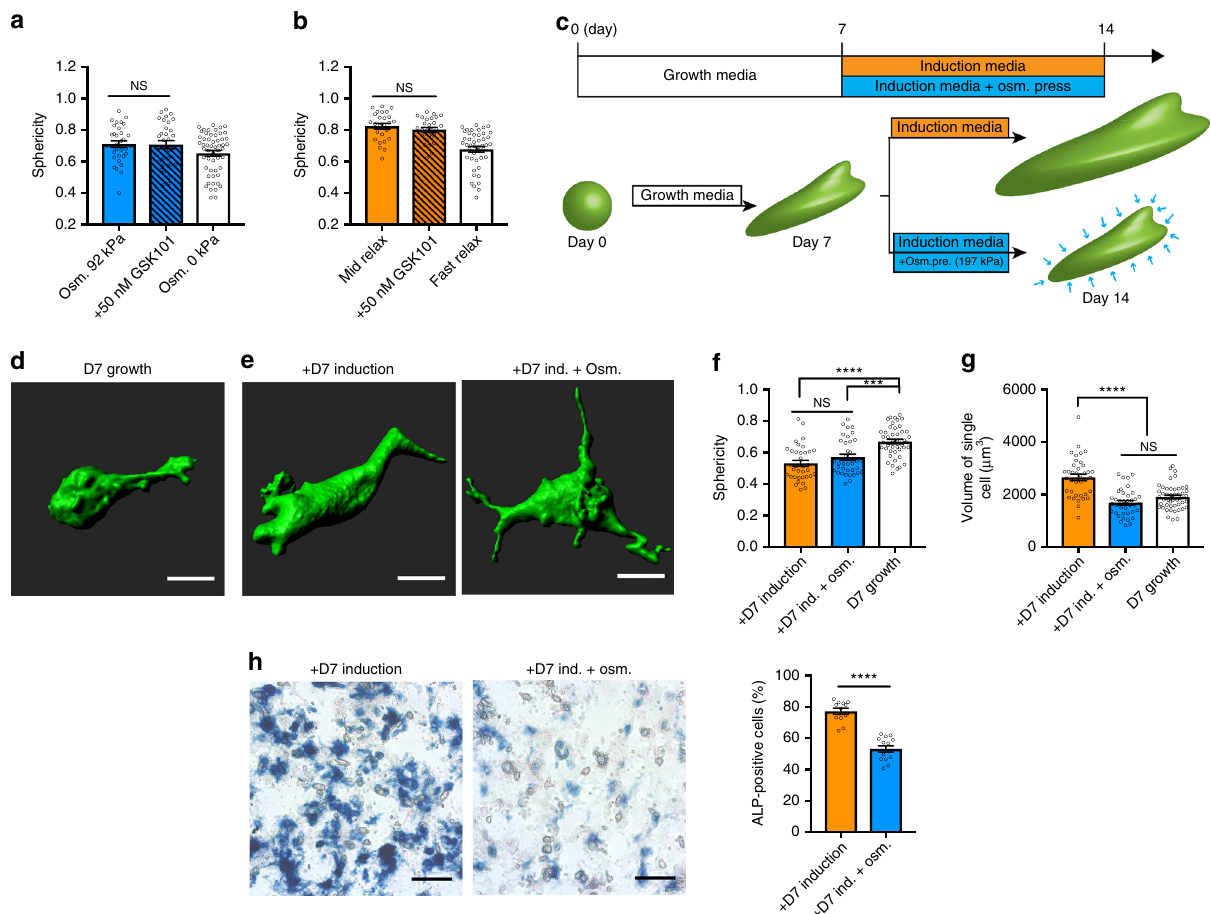
Fig. 5 Volume expansion regulates osteogenesis of MSCs independent of morphology. a , b Quanti fi cation of sphericity of single cells cultured in fast- relaxing hydrogel under osmotic pressure of 92 kPa ( a ) and in mid relaxing hydrogel under osmotic pressure of 0 kPa ( b ) with or without treatment of TRPV4 agonist for 7 days ( n ≥ 25 single cells from three biological replications per each condition, NS p >0.05 by Student's t test). c Schematic of protocol for delayed exposure of osmotic pressure to restrict volume expansion during differentiation after culturing MSCs in growth media for 7 days. d , e Representative 3D images of a single cell cultured in fast-relaxing hydrogel with growth media for 7 days ( d ) and cultured with induction media with or without osmotic pressure for additional 7 days. f , g Quanti fi cation of sphericity ( f ) and volume ( g ) of single cells cultured in indicated conditions ( n ≥ 35 single cells from three biological replications per each condition, **** p <0.0001, *** p <0.001, and NS p >0.05 by one-way ANOVA test). h Representative images of ALP staining and quanti fi cations of the percentage of cells positively stained for ALP of MSCs cultured in indicated conditions ( n ≥ 10 images from three biological replications per each condition, **** p <0.0001 by Student's t